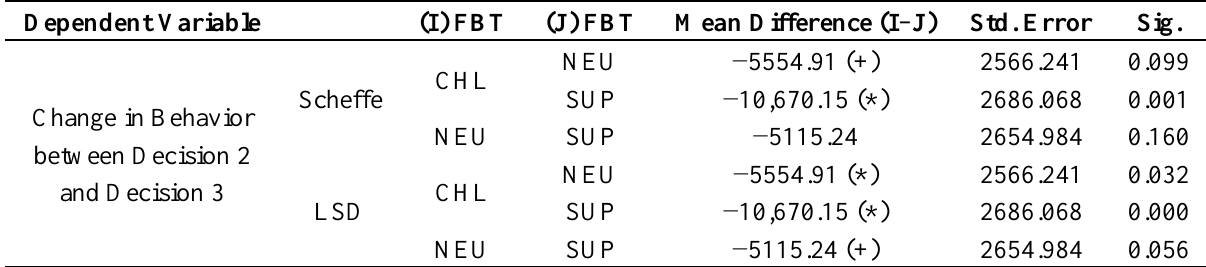
Table 5. Significant Paired Comparisons for Feedback Type.